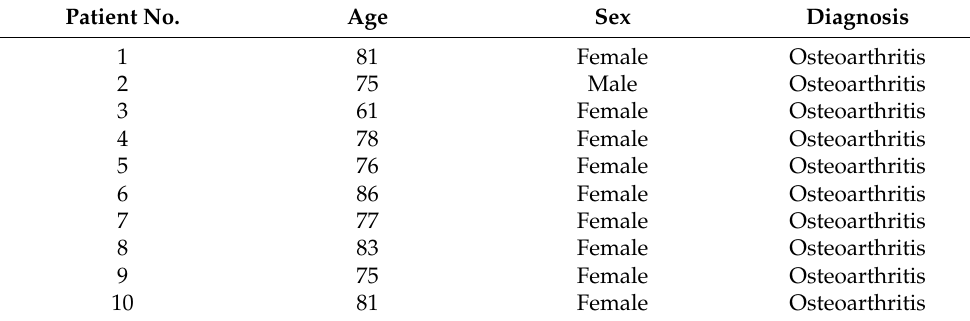
Table 1. Baseline characteristics of patients in the current